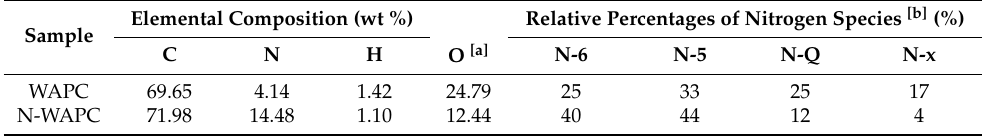
Table 1. Elemental composition and relative percentages of nitrogen species of the carbon samples.